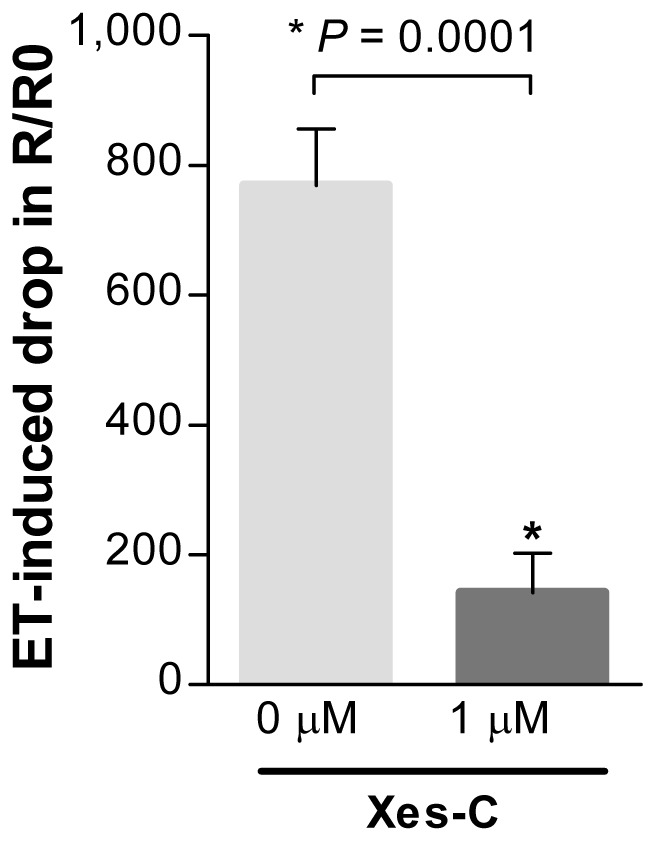
Ca2+ depletion waves propagate via IP3Rs.Inhibition of IP3Rs with Xes-C (1 µM) blocks ET-induced depletion waves as compared to vehicle-control groups. For Xes-C treated groups, cells were perfused with nominal Ca2+ free buffer containing 1 µM Xes-C starting 5 min prior to addition of ET-1 (n = 5 cells from five independent experiments, mean ± SEM, *P = 0.0001).